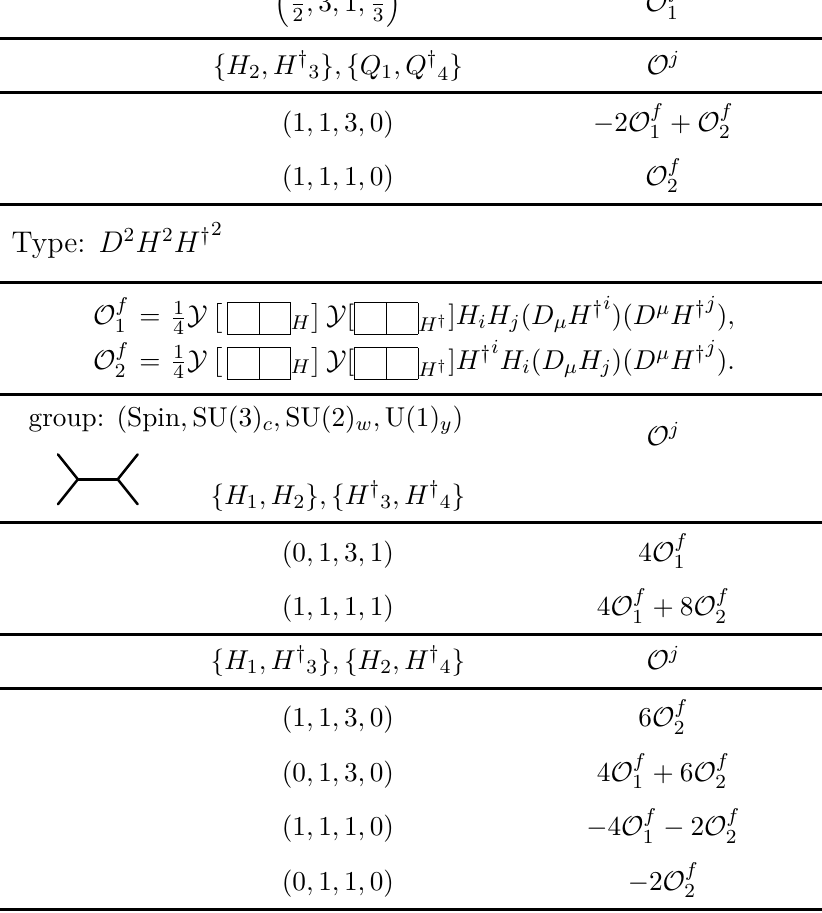
Table 22. UV resonance of topology dim6-4. “*” in front of each row indicates topologies with nonrenormalizable vertices. The UV resonances colored in gray are eliminated by UV